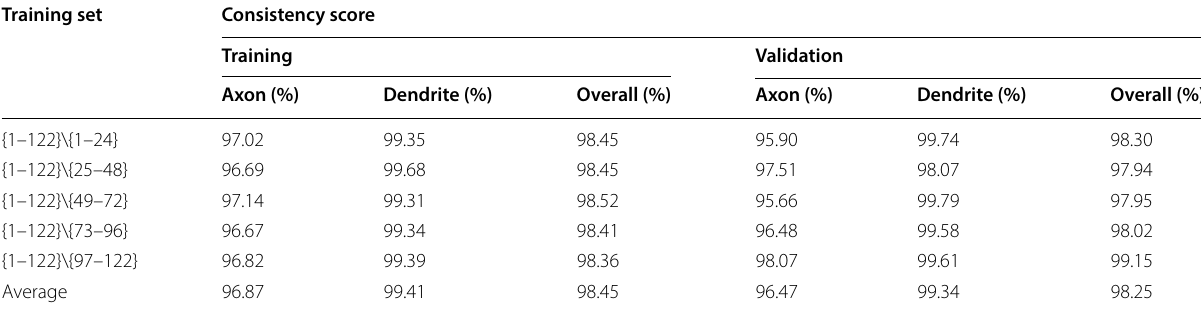
Table 2 Fivefold cross-validation on 122 manual reconstructions of biocytin-labeled mouse neuron dataset Training set